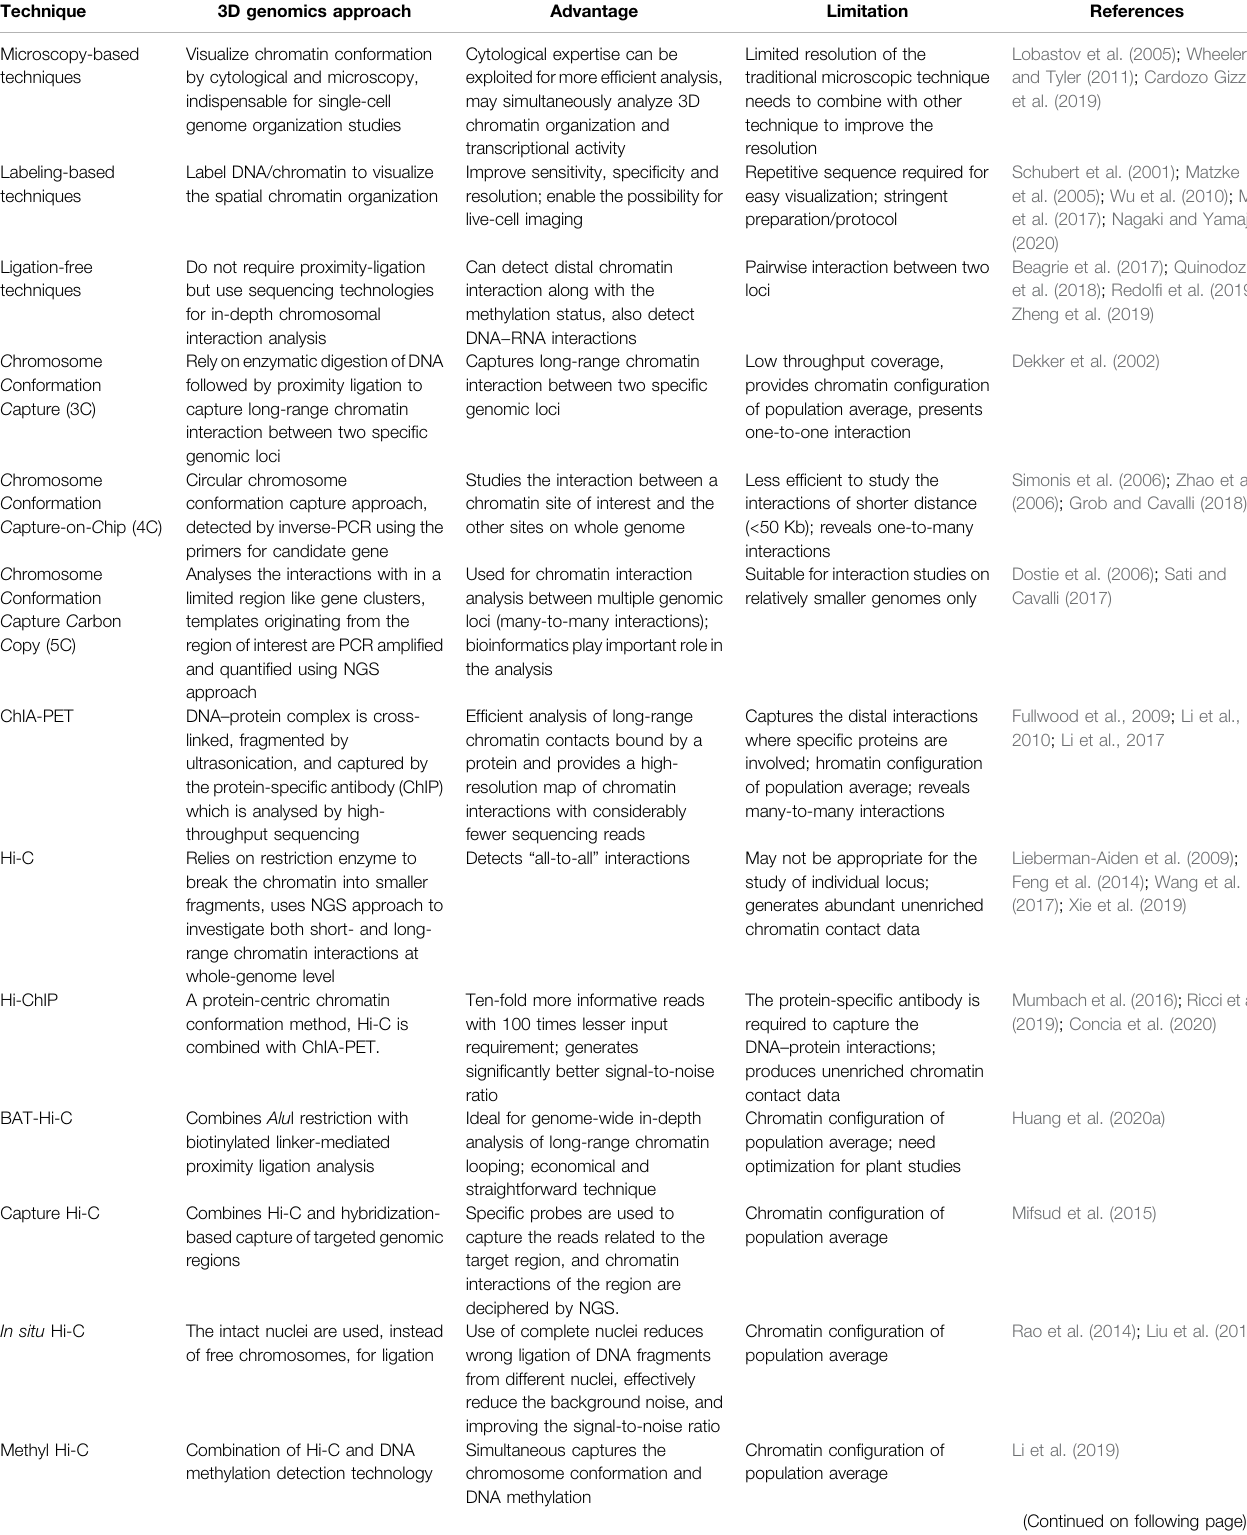
TABLE 1 | Characteristic features of different techniques used for 3D genome organization